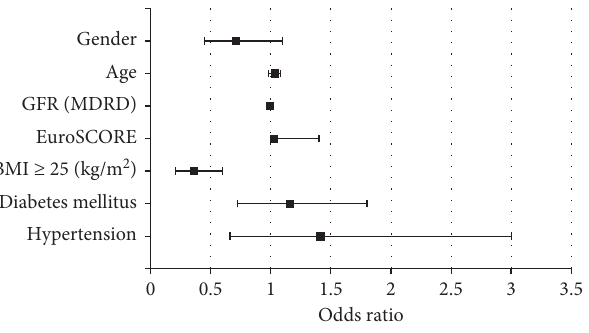
Figure 2: Odds ratio for 1-year mortality in study patients. Table 2: Multivariate Cox proportional hazard